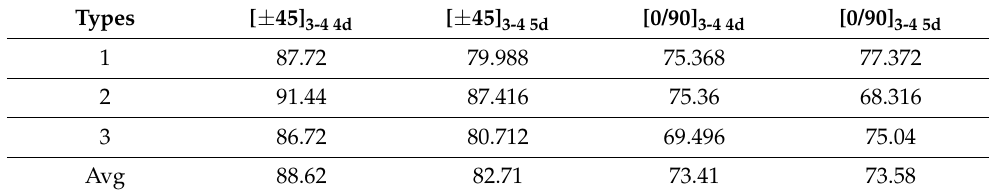
Table 8. Ultimate load of [0/90] and [ ± 45] GFS expansion of the strengthening areas of